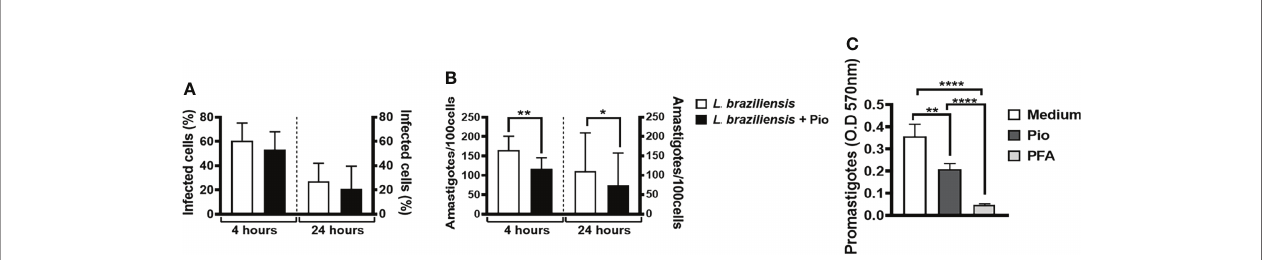
FIGURE 5 | Pioglitazone has cytotoxic effects in Leishmania braziliensis parasites. Monocytes from healthy subjects (HSs) (n = 12) were cultured for 4 or 24 h in the presence or absence of L. braziliensis (5:1) and pioglitazone (1 m M). (A) The infection rate and (B) the number of amastigotes were determined by 3 different observers using optical microscopy. (C) L. braziliensis (n = 6) were cultured in the presence or absence of pioglitazone (1 m M) or paraformaldehyde (PFA) (3%) for 24 h. (C) OD of promastigotes form. The box represents the mean, and the line above the box is the SD. Statistical analyses were performed using the ANOVA test. *p < 0.05 and **p < 0.01.